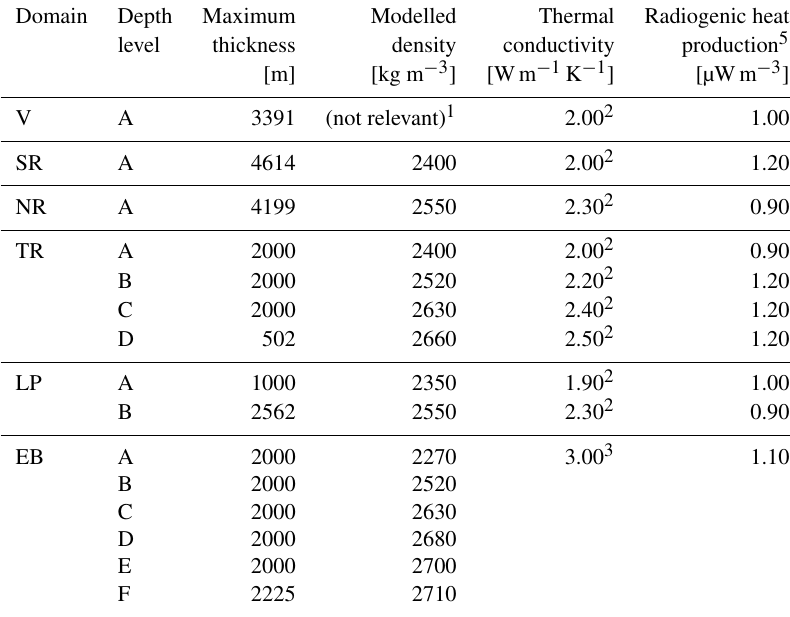
Table 2. Properties of the modelled sedimentary and volcanic basin domains.